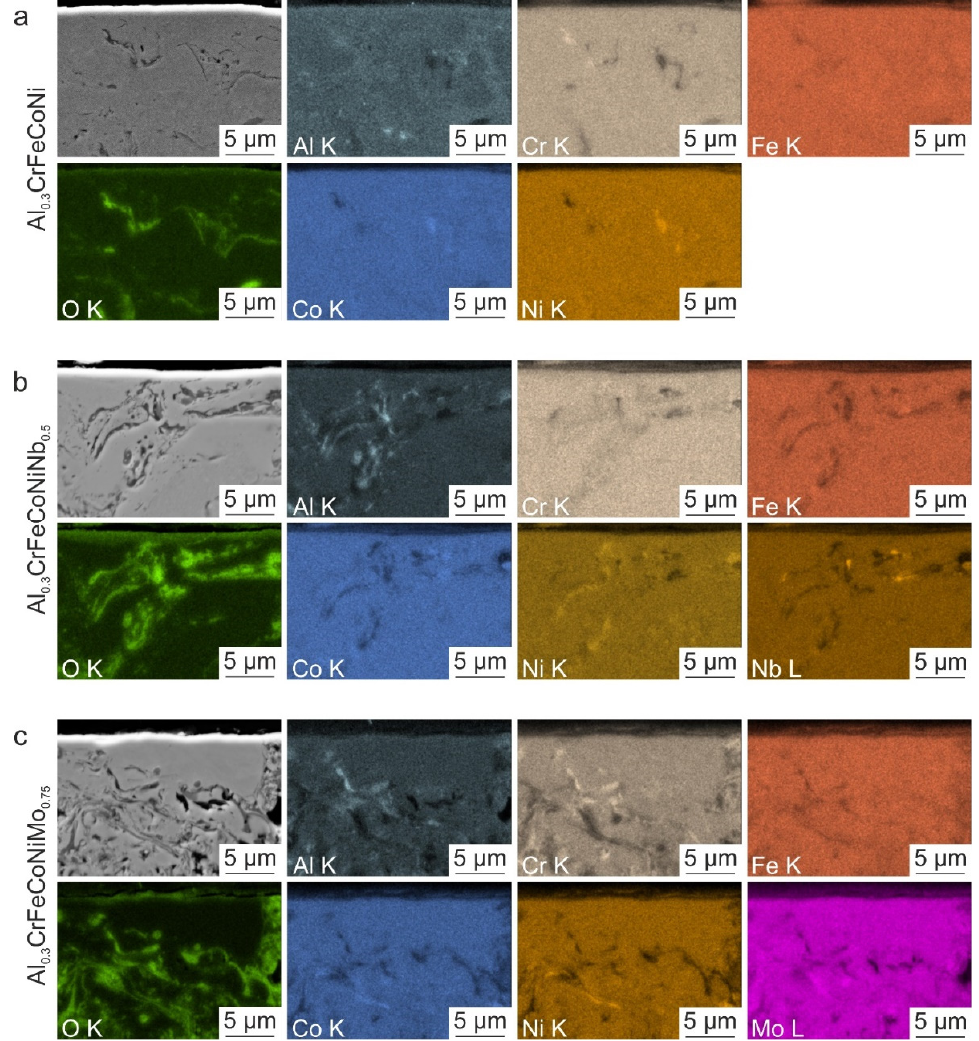
Figure 2. EDS maps of the HVOF-sprayed ( a ) Al 0.3 CrFeCoNi, ( b ) Al 0.3 CrFeCoNiNb 0.5 and ( c ) Al 0.3 CrFeCoNiMo 0.75 in the near-surface area. The alloying elements are homogeneously distributed in all the HEA coatings investigated. However, some elements, e.g., Al, are enriched in the oxide